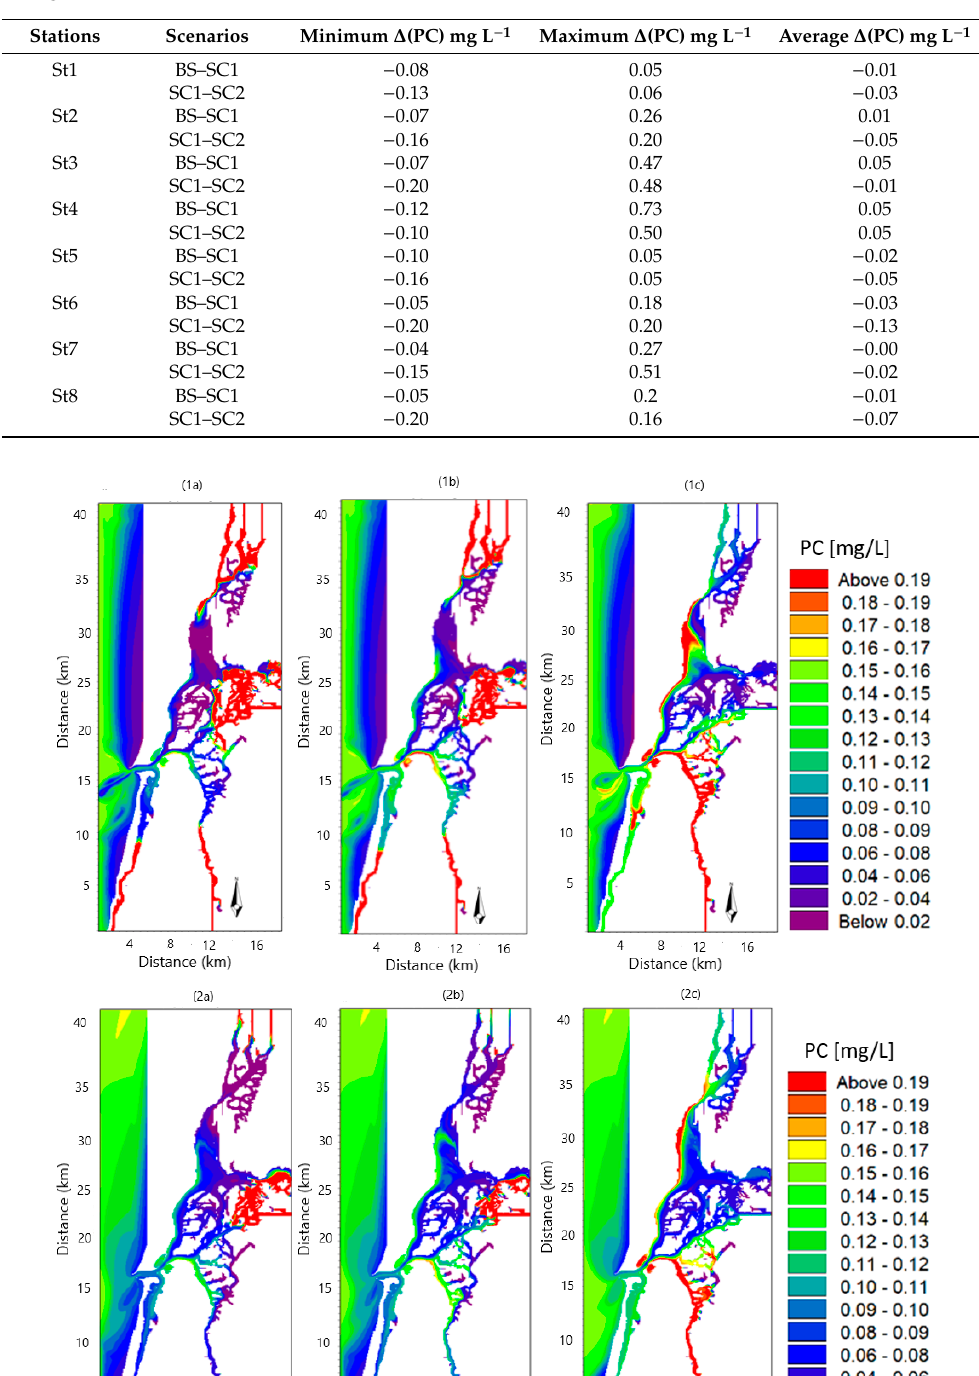
Table 8. Carbon phytoplankton concentration di ff erence, ∆ (PC), metrics for BS–SC1 and SC1–SC2, and the lagoon stations (St1–St8).